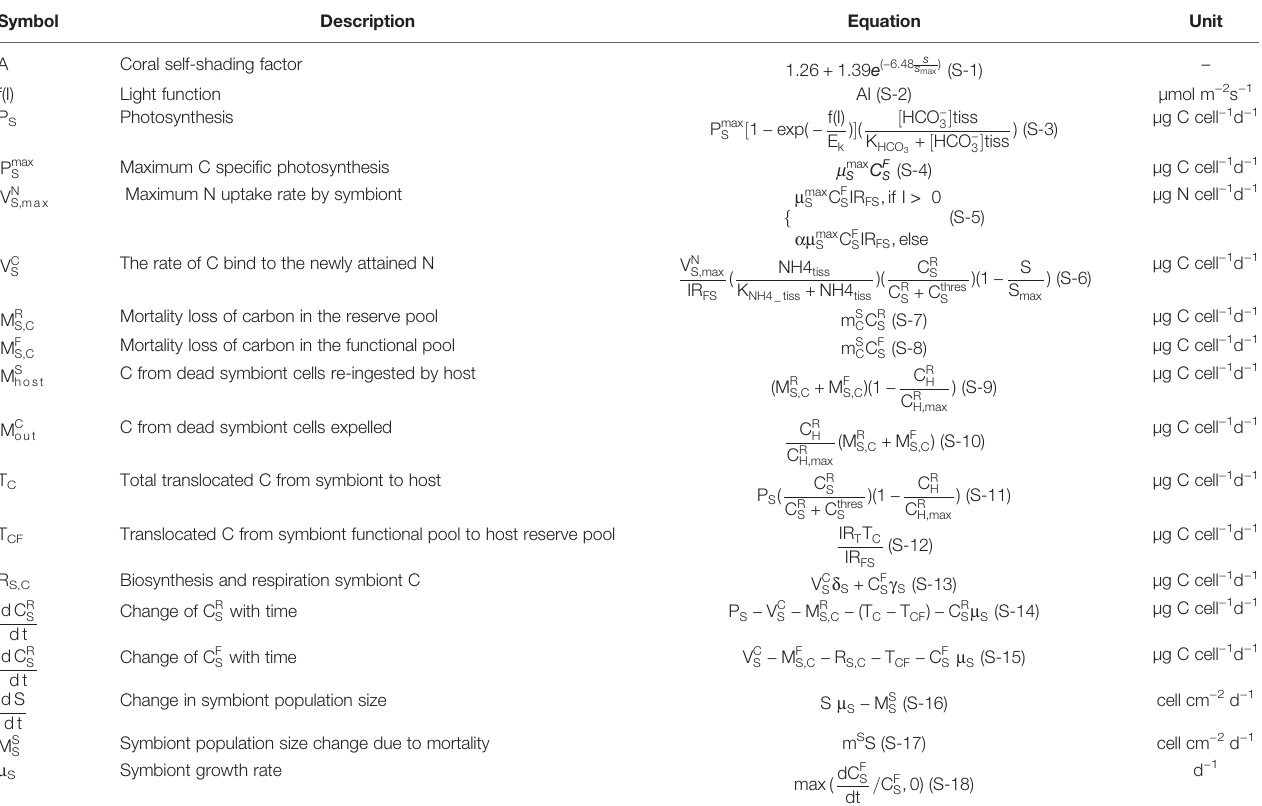
TABLE 3 | Model equations for